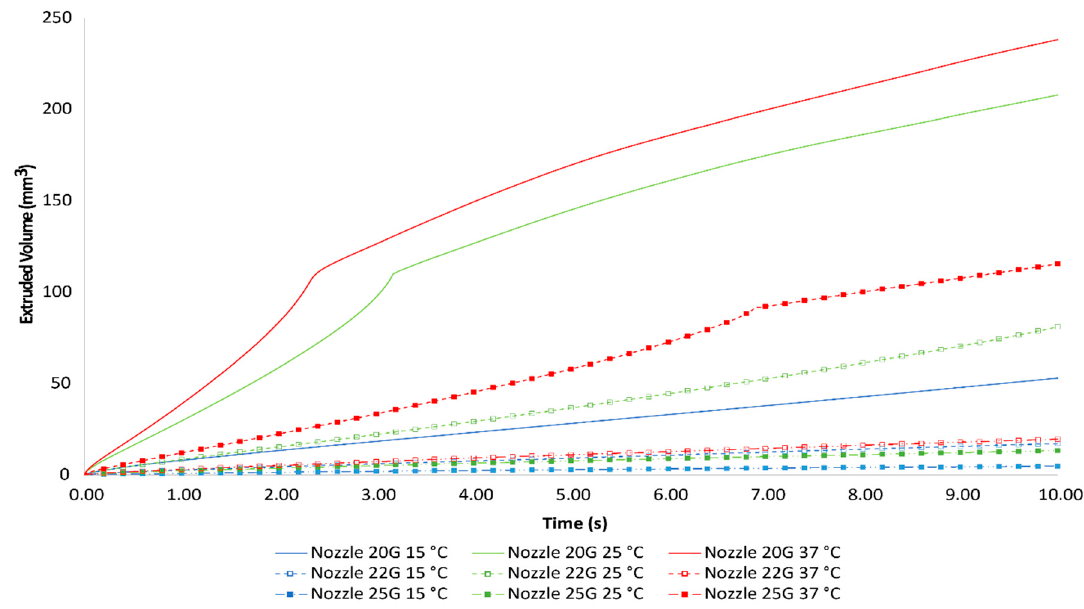
Figure 5. Total extruded volume for 20, 22, and 22G conical tips using Cellink Bioink at 15, 25, and 37 °C. Table 3. Cellink Bioink extruded volume (mm 3 ) and time (s).